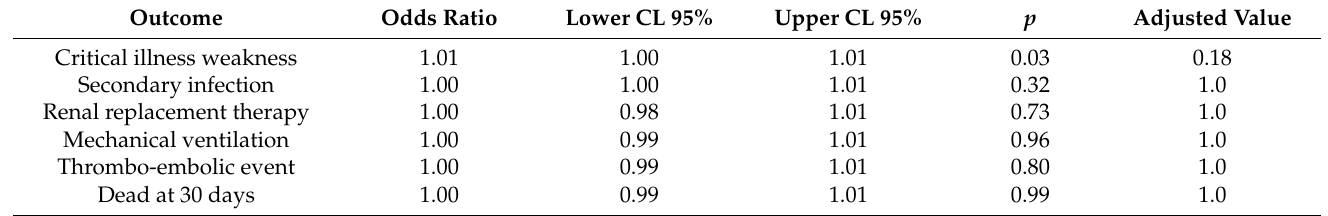
Table 2. Plasma leptin in relation to clinical outcomes. CL = confidence limits. p -values were adjusted using the Bonferroni